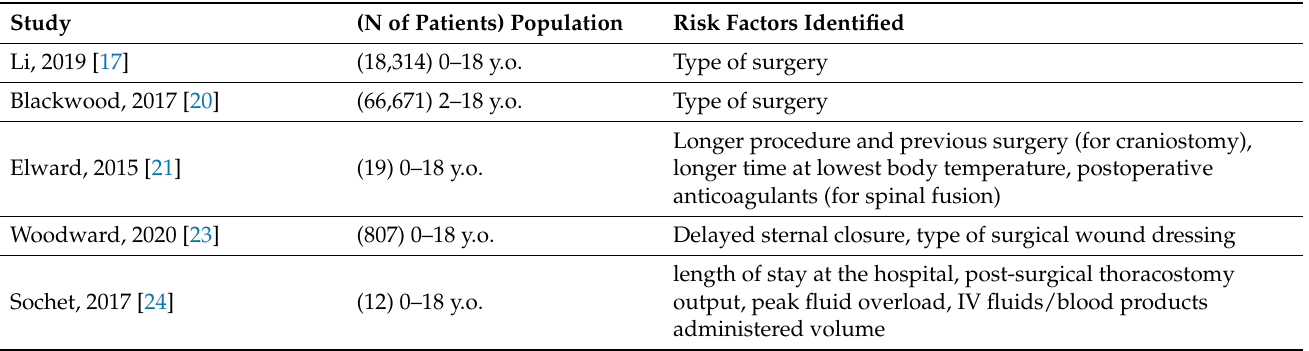
Table 2. Risk factors for SSIs in children and